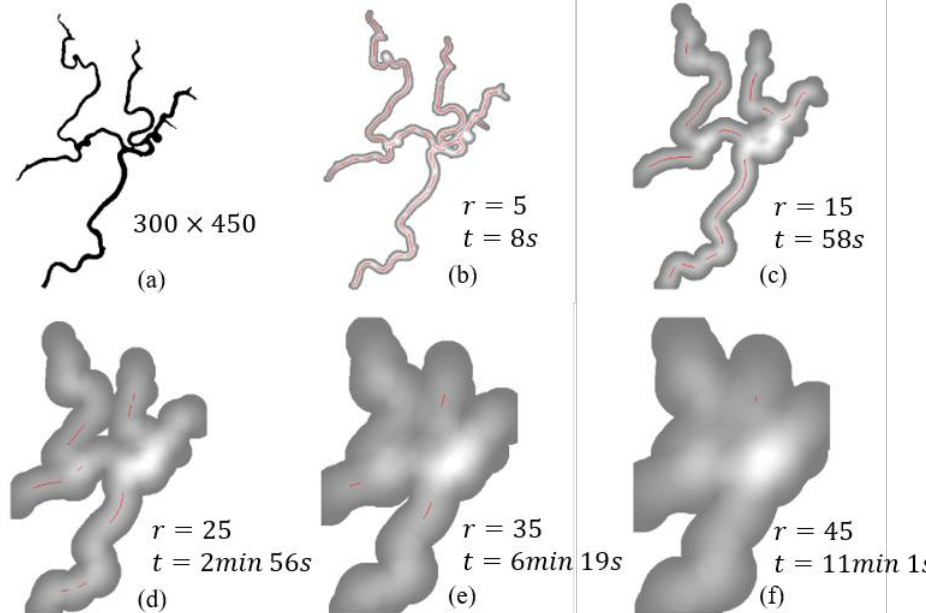
Figure 6. The impacts of over-large kernel size. ( a ) A complicated lotic habitat for experiment, and the magnitude surface generated from the kernel radius ( b ) r = 5, ( c ) r = 15, ( d ) r = 25, ( e ) r = 35 and ( f ) r = 45. As the kernel size linearly increases, the loss of the centerline and the time cost both increase exponentially.